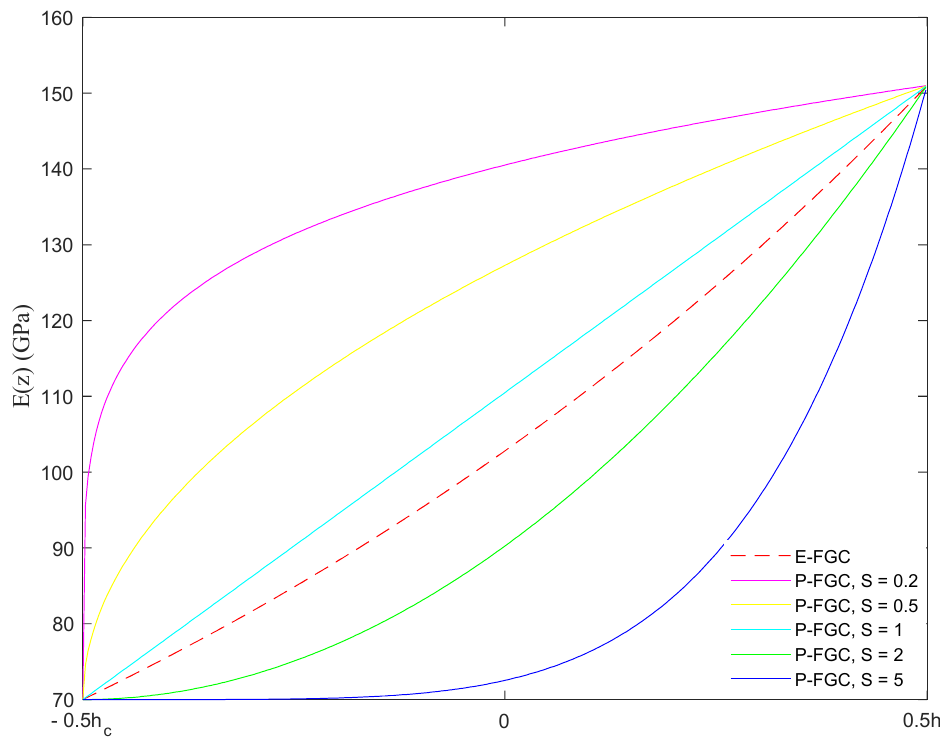
Figure 2. Variation of the elasticity modulus with the core thickness based on the E-FGC and P-FGC models. The sandwich beam system includes two CNTRC faces, with increased overall stiffness. Both external skins are assumed to be completely bonded to the FGC without any possible interlayer slip. The presence of CNTs within the PMMA matrix plays an efficient role in the general improvement of the mechanical properties. Due to the high aspect ratio of CNTs, their bending and bundling within the matrix phase and clusters formation seem to be almost predictable. In this paper, we consider the effect of the CNTs’ agglomeration on the overall mechanical response, based on an EMT scheme [26]. Based on this approach, the bulk modulus K and shear modulus G inside and outside the clusters Table 1. Possible combinations of µ and η . can be defined as [26,27]: Case Result µ = 0 No-agglomerated composite. µ = 1 The whole composite layer serves as a big agglomerated region. There is no CNT inside the clusters. All CNTs are agglomerated inside the clusters. Fully CNTs agglomerated